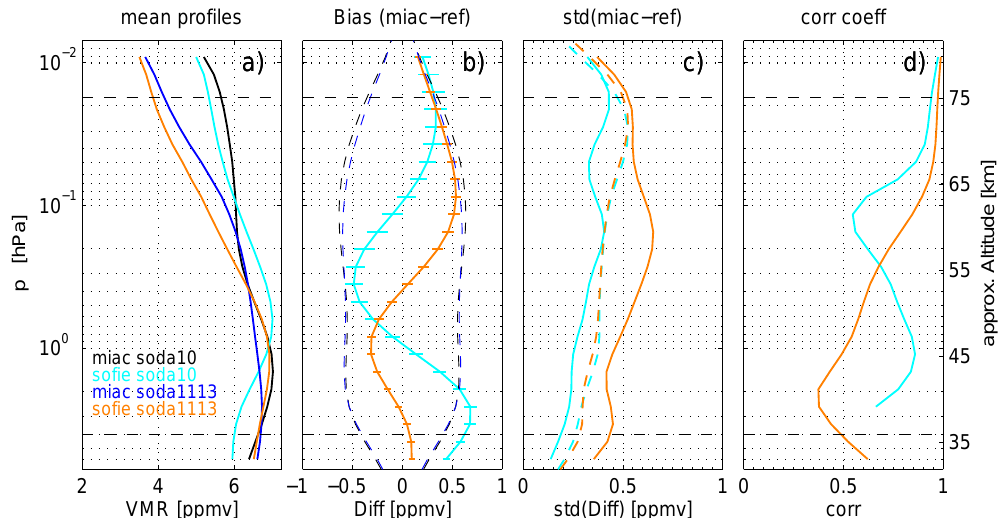
Fig. 14. Intercomparison MIAWARA-C – SOFIE for Sodankyl¨a10 and Sodankyl¨a11–13. (a) Mean coincident profiles of SOFIE (cyan)/MIAWARA-C (black) for 2010 and of SOFIE (orange)/MIAWARA-C (blue) for 2011–2013. (b) Bias (solid) and its standard er- ror (horizontal) with for 2010 (cyan) and 2011–2013 (orange) together with the estimated systematic error of MIAWARA-C (black dashed for 2010, blue dashed for 2011–2013). (c) Standard deviation of differences (solid; cyan for 2010, orange for 2011–2013) and combined random error of the instruments (dashed). (d) Correlation coefficients (cyan for 2010, orange for 2011–2013). All plots use MIAWARA-C data with AoA > 0.5. The dashed horizontal lines indicate the reliable altitude range (AoA > 0.8).